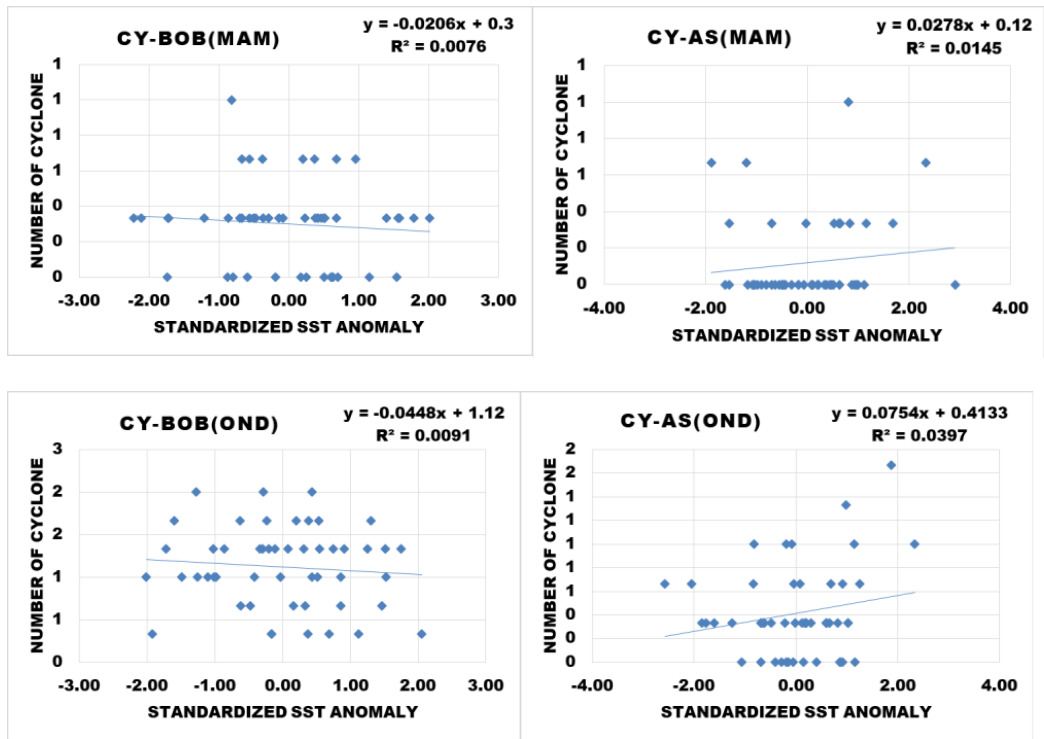
Figure 3. Scatter plots between standardized SST anomalies and number of cyclones (CY) for all the years (1971 – 2020) together for BOB − MAM, AS − MAM, BOB − OND and AS − OND.